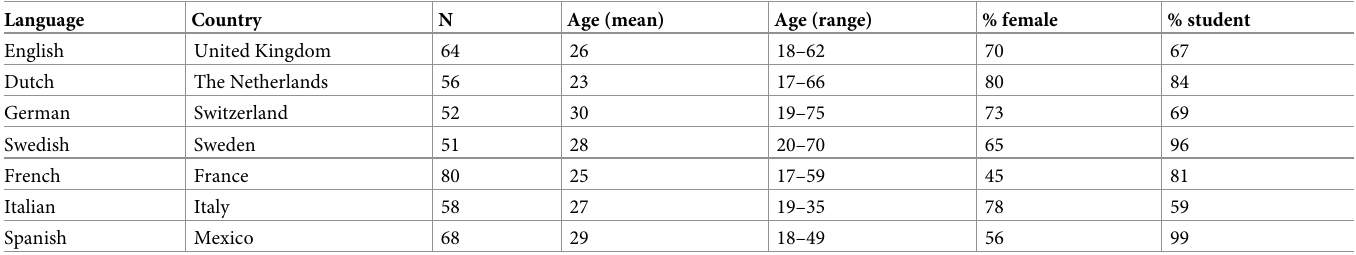
Table 1. Demographic details of the